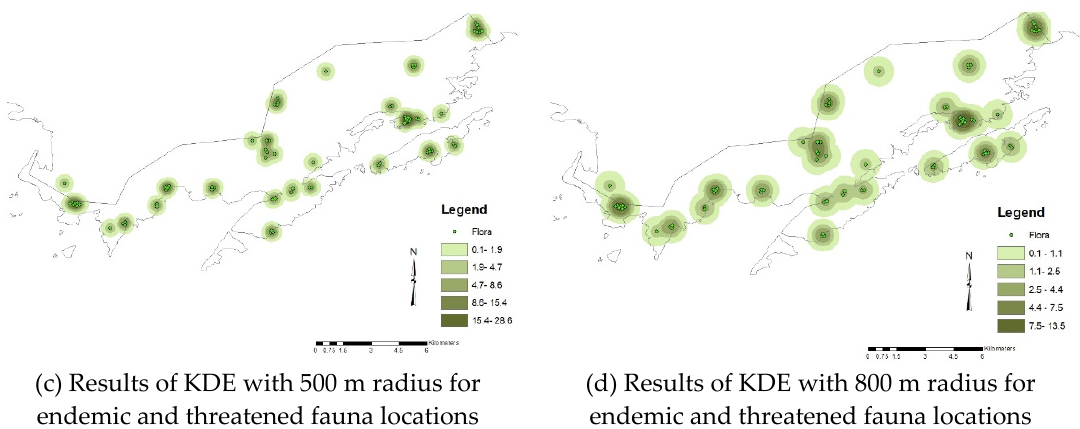
Figure 10. The results of KDE bandwidth analyses with fauna data (all species types were included in the results) and endemic flora locations. The results were classified according to natural breaks.